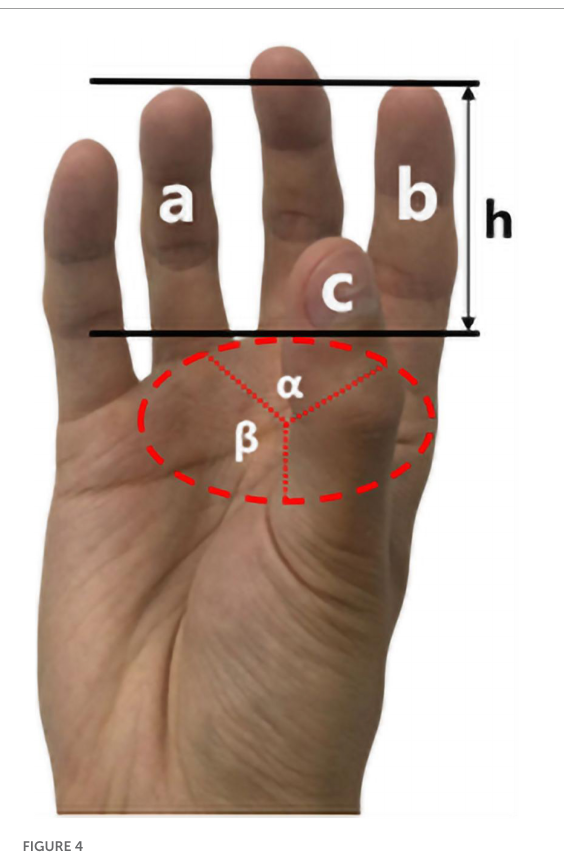
FIGURE4 Semi-enclosed grip type for fingers and